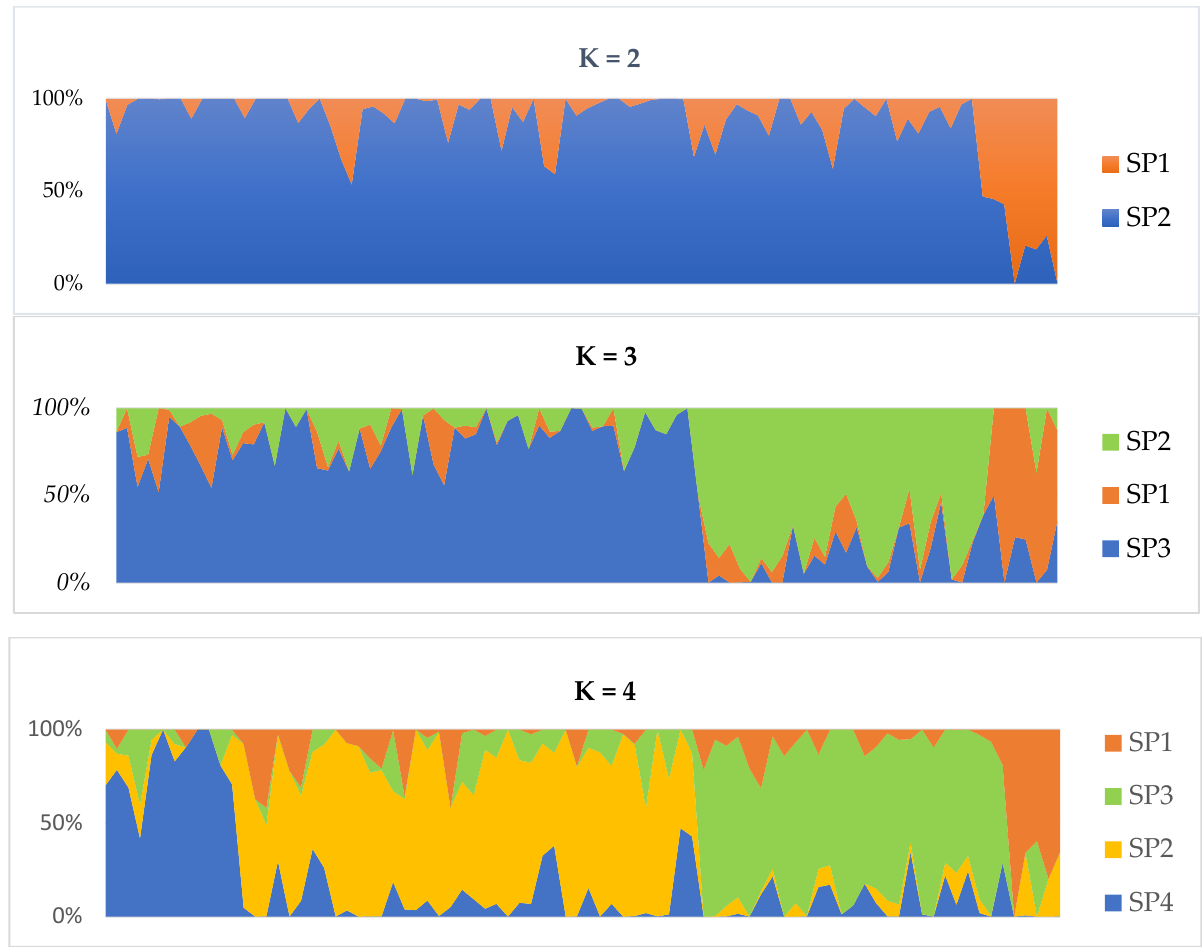
Figure 1. Population structure analysis using a Bayesian-based approach. Population structure analysis of 90 cowpea accession from K = 2 to K = 4 based on inferred ancestry (Q matrix). However, the distance-based cluster analysis generated using Nei’s genetic distance using a neighbor-joining algorithm revealed the presence of three distinct clusters in the population represented by the 90 accessions (Figure 2). The clustering patterns of the two approaches were similar and constituted similar sets of accessions. For example, C1 (red) contained 41 accessions, 5 accessions from SP1, 27 from SP4, and 9 from SP3 of the STRUCTURE-generated clusters. C2 (black) consisted of 24 accessions, of which 18 accessions from SP2 and 5 were from SP3. C3 (blue) contained 26 accessions all from SP3. The discrepancy between the two clustering approaches could result from admixtures 100 since only 43% of the tested genotypes were considered pure. The clustering patters did not match the geographic origins of the accessions. C1 consisted of 95% South African, 2% Nigerian, and 2% Tanzanian accessions. The majority of the accession (92%)) clustered in C3 were collected from South Africa and 4% from Nigeria and Tanzania each. However, C2 was dominated with accessions from South Africa (52%), Nigeria (39%), and Kenya